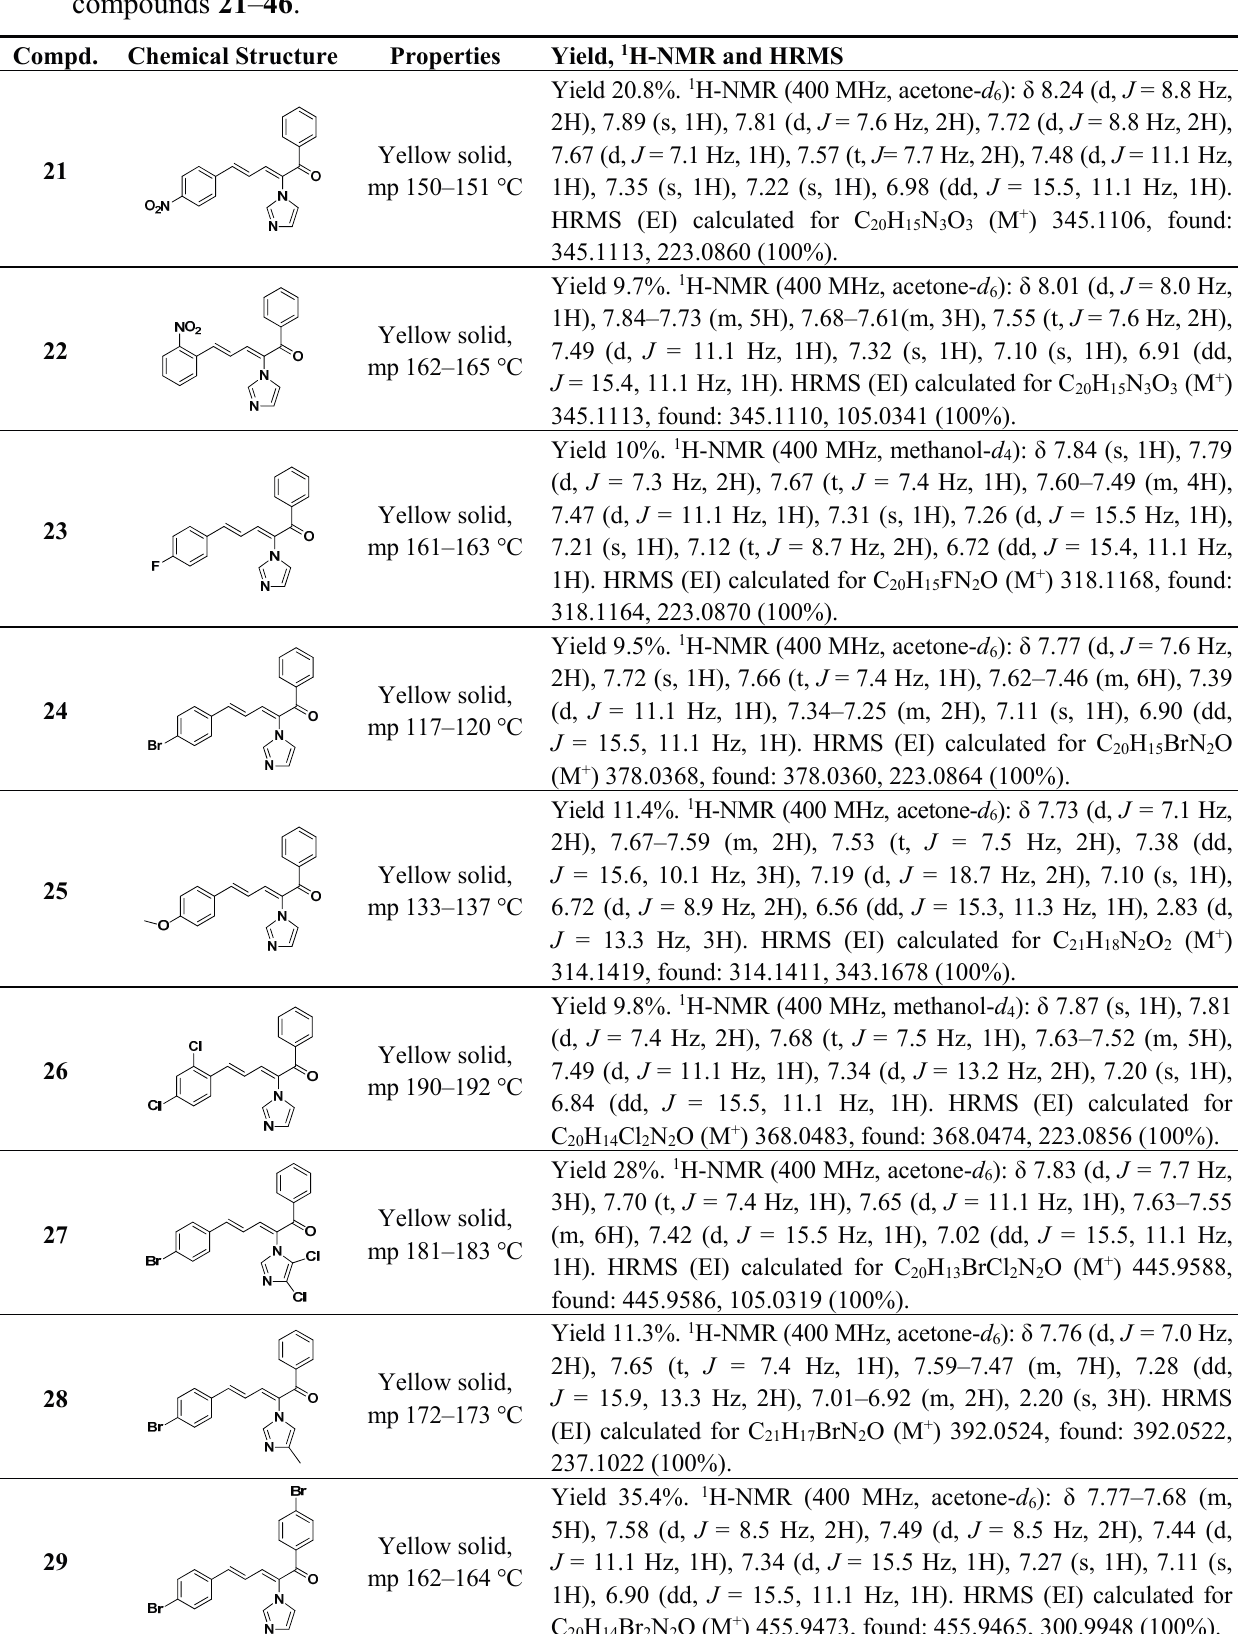
Table 6. The chemical structures, properties, yields, 1 H-NMR and HRMS of target compounds 21 – 46 .